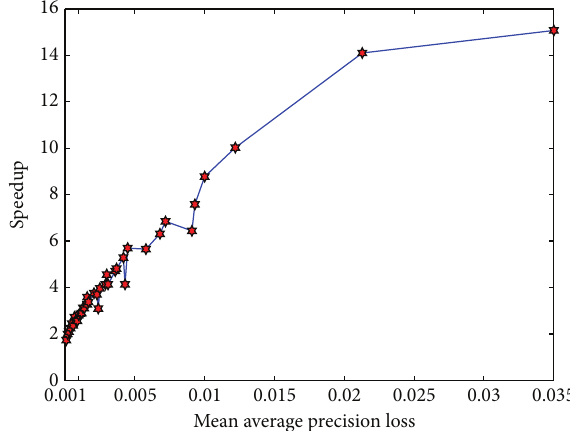
Figure 8: Performance comparison with GPU-based brute force